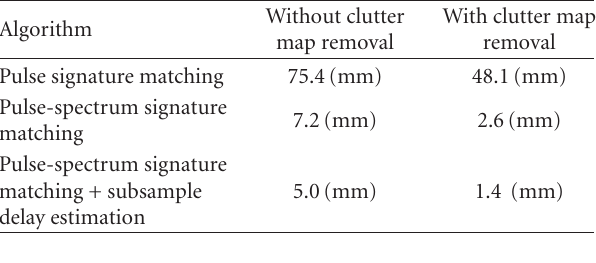
printed from the screen is shown in Figure 17 (right) for